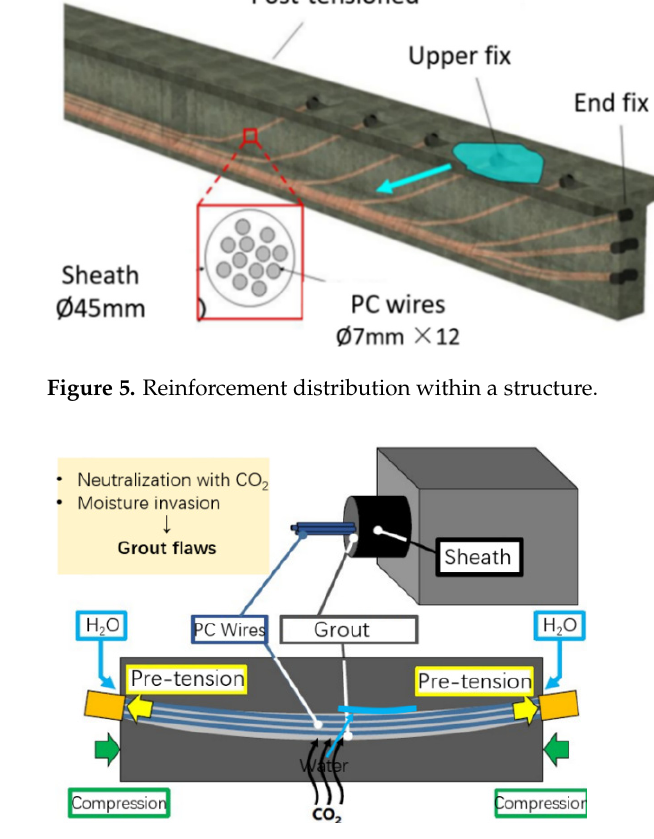
Figure 6. Side cross-section of a sheath inside a PC structure.